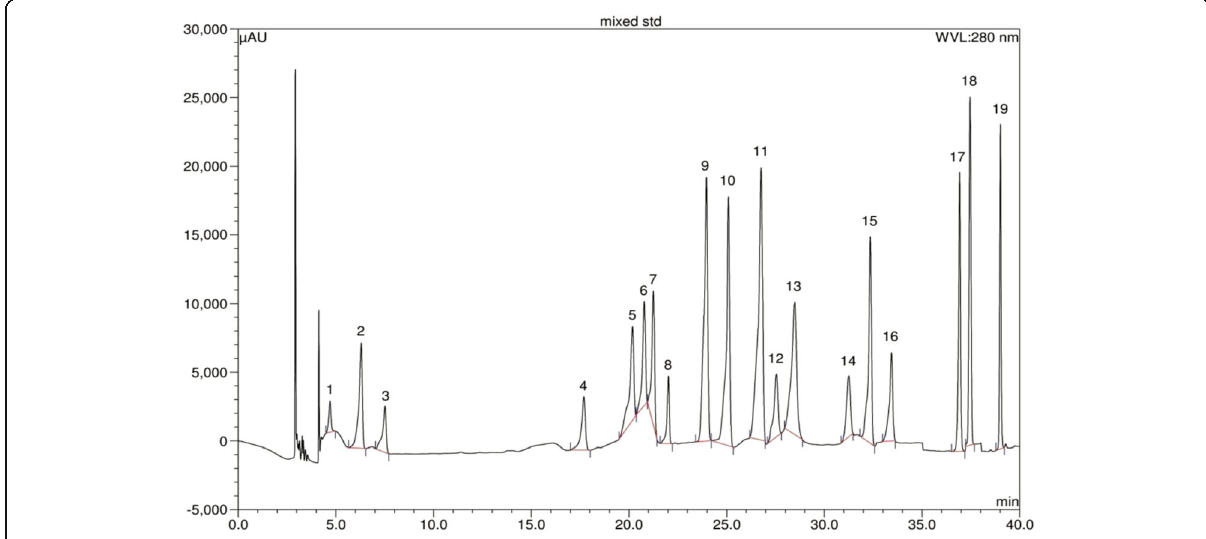
Fig. 1 HPLC chromatogram of a standard mixture of polyphenolic compounds. (Peaks: 1: arbutin; 2: gallic acid; 3: hydroquinone; 4: (+)-catechin; 5: vanillic acid; 6: caffeic acid; 7: syringic acid; 8: ( − )-epicatechin; 9: vanillin; 10: p -coumaric acid; 11: trans -ferulic acid; 12: rutin hydrate; 13: ellagic